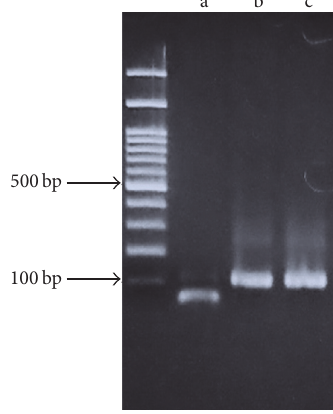
Figure 4: Restriction digestion and gel electrophoresis of the PCR amplified products using SS-G (a), SS-abasic site (b), or the biotinylated DS-G/abasic site (c) as the template. The restriction enzyme MspI which recognizes the CCGG sequence was used to cleave the PCR amplified